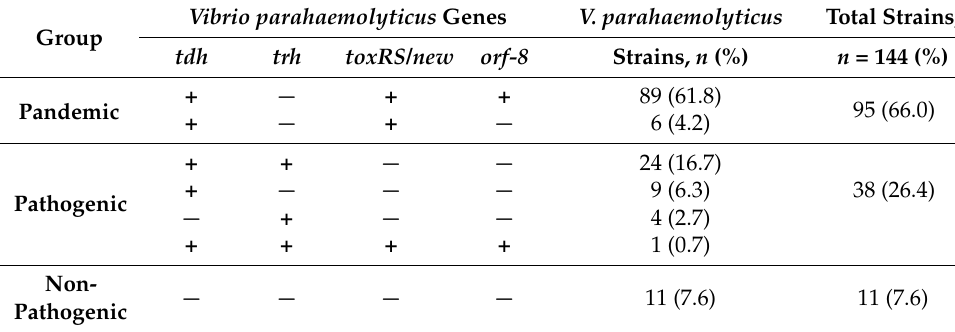
Table 3. Vibrio parahaemolyticus groups isolated from diarrhea cases in Mexico from 2004 to 2011.